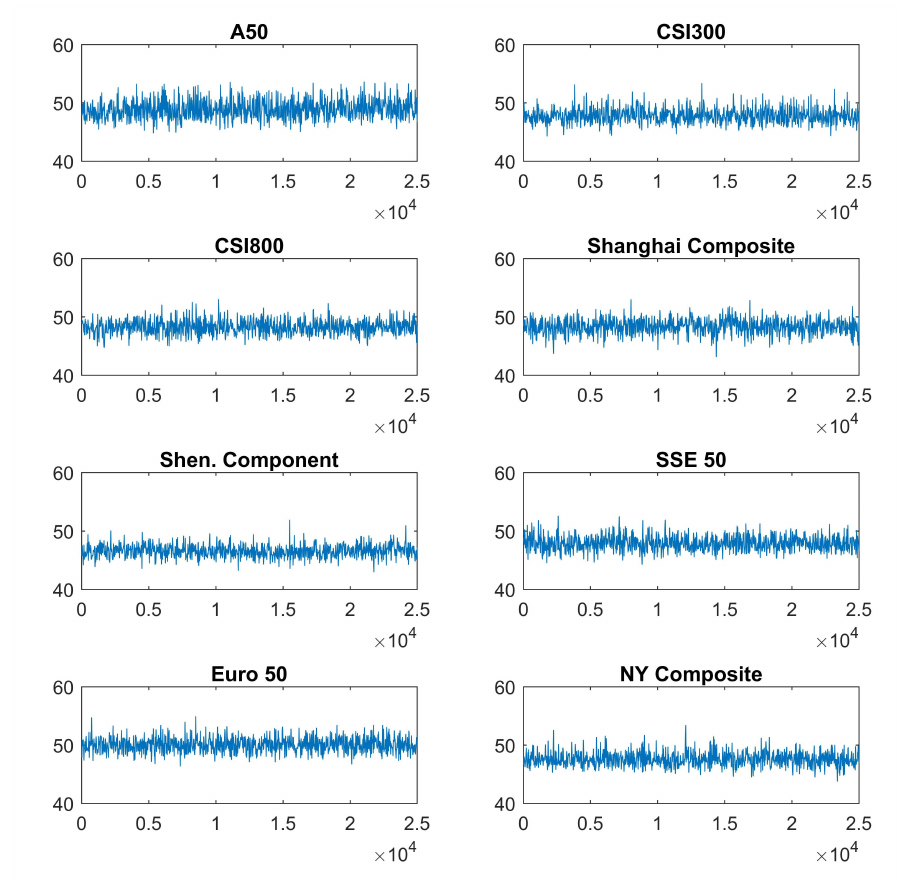
Figure 2. Sensitivity analysis of the error rate (using directly neural networks) as the number of neurons is